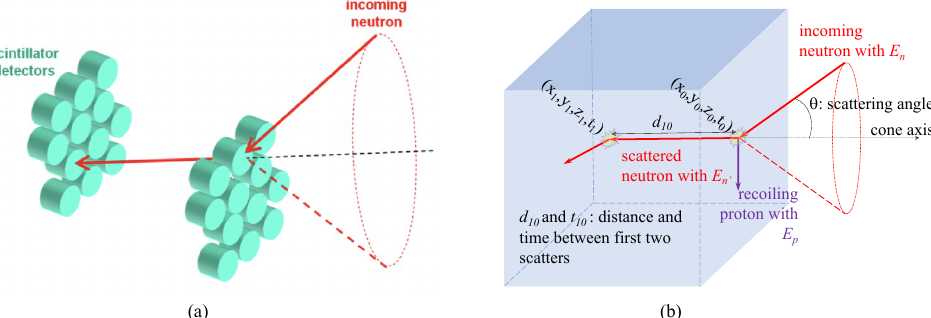
Figure 1. Neutron double scatter imaging is illustrated in ( a ), for a traditional detector configuration, comprising two planes of cylindrical organic scintillator detectors. The kinematics of neutron elastic scattering allow the incidence angle of neutrons that scatter in both detector planes to be constrained to conic volumes, where successive coincidence measurements facilitate source localization through spatial correlation of overlapping projections [1,2]. A neutron double scatter camera, conceptualized from a monolithic block of plastic scintillator, is illustrated in ( b ). In this detector configuration, coincidence detection efficiency, and thereby imaging sensitivity, can be increased by more than an order of magnitude. Localizing neutron scatter sites through resulting spatiotemporal distributions of generated scintillation light provides the kinematic information for image reconstruction